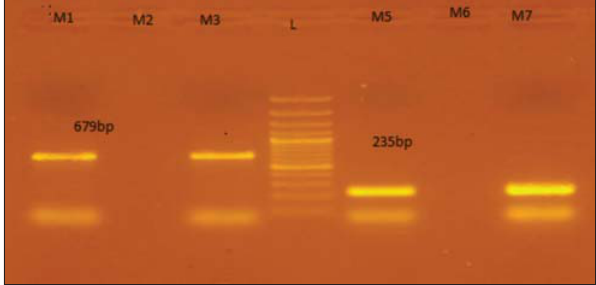
Figure-3: Amplified product of Streptococcus equi and Streptococcus zooepidemicus. Lane M1, M3: Amplified product of S. equi for SeM gene at 679 bp, Lane M2, M6: Negative sample, Lane M5, M7: Amplified product of S. zooepidemicus for sodA gene at 235 bp, Lane L: Molecular weight marker of 100 bp, (Himedia India). Table-3: Distribution of S. equi subsp. equi as detected by amplification of SeM gene from apparently healthy and diseased equines. Region